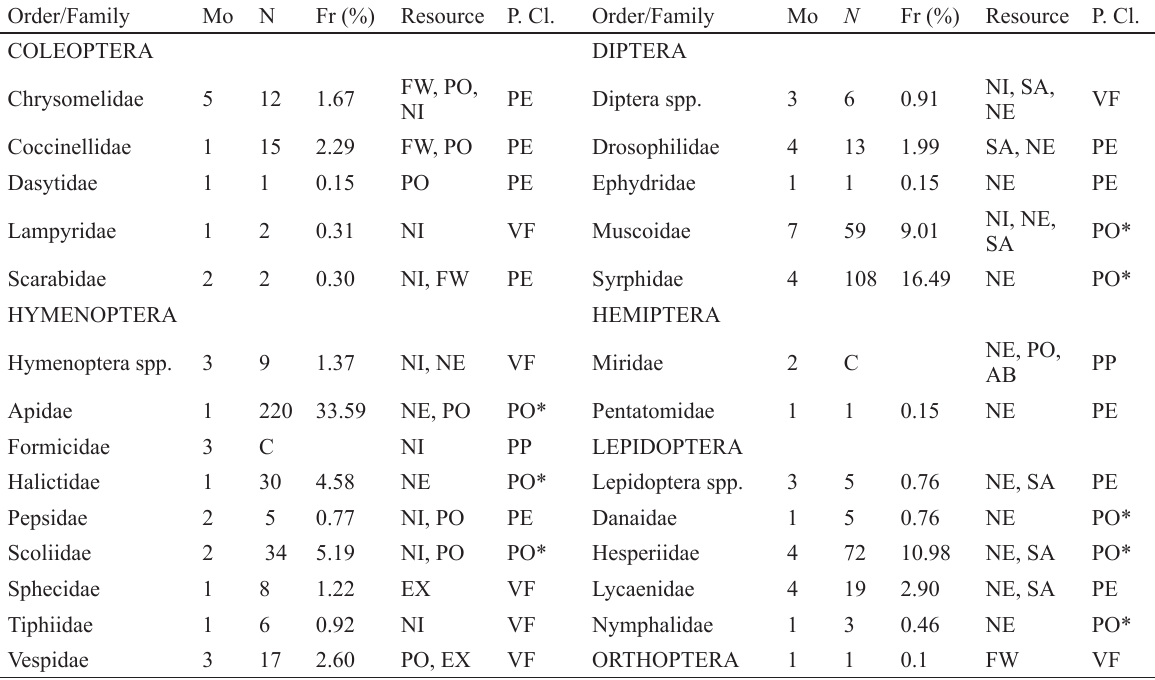
Varronia curassavica Jacq. floral visitors in a sandbank environment, Joaquina, Florianópolis, Santa Catarina,